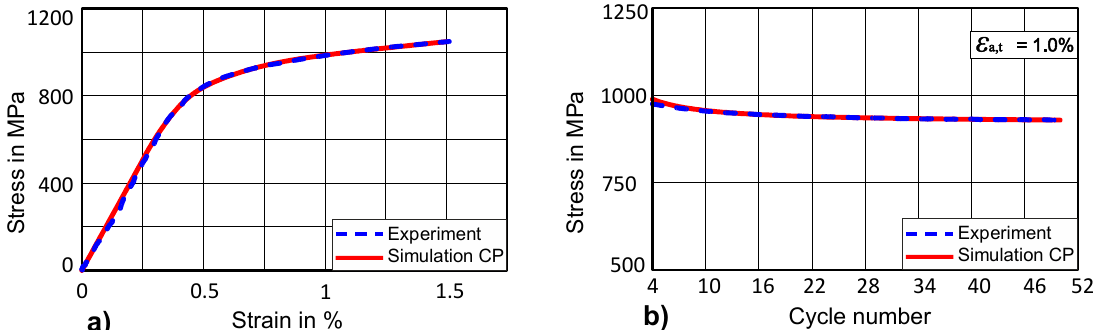
Figure 11. ( a ) Optimised uniaxial stress-strain curve for CP at ε a,t = 1.5%; ( b ) Evolution of stress amplitude for (CP) first 50 cycles